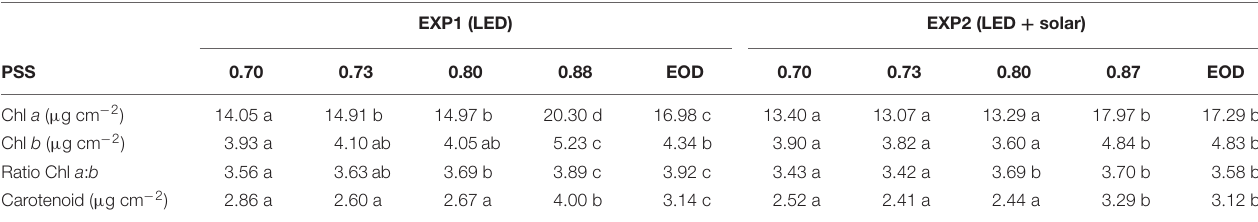
TABLE 3 | Chl a , b and carotenoid content of leaf disks cut from leaf 4 of tomato plants in relation to four levels of PSS and EOD-FR treatments without solar light (EXP1) or with solar light (EXP2). EXP1 (LED)